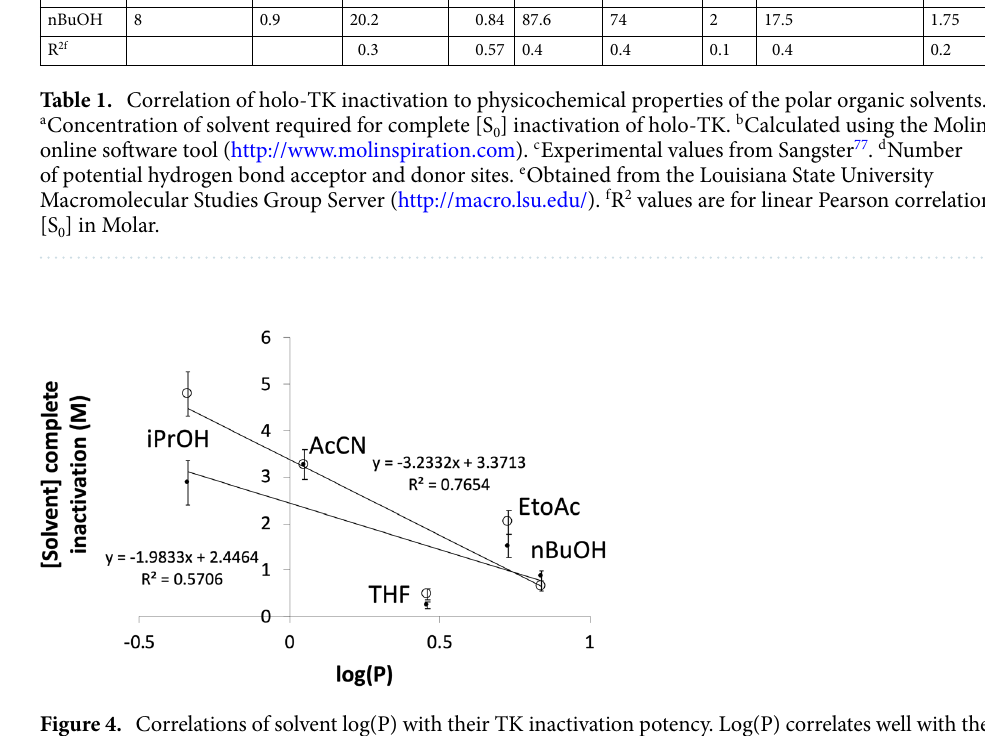
Figure 4. Correlations of solvent log(P) with their TK inactivation potency. Log(P) correlates well with the molar concentration required to inactivate either (open circle) holo-TK or (filled circle) apo-TK. Error bars represent one standard deviation about the mean (n =